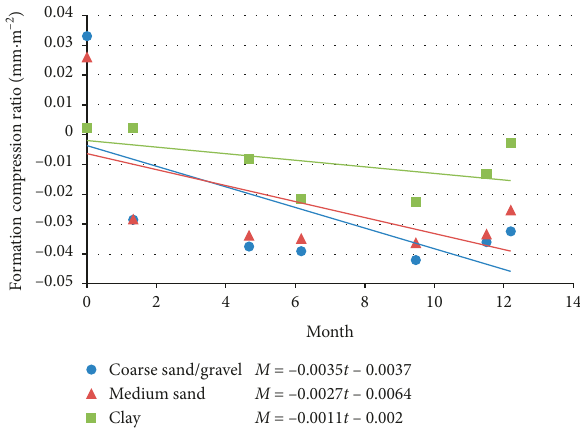
Figure 11: Compression rate of the west ventilation shaft in the Xinglongzhuang Coal Mine.